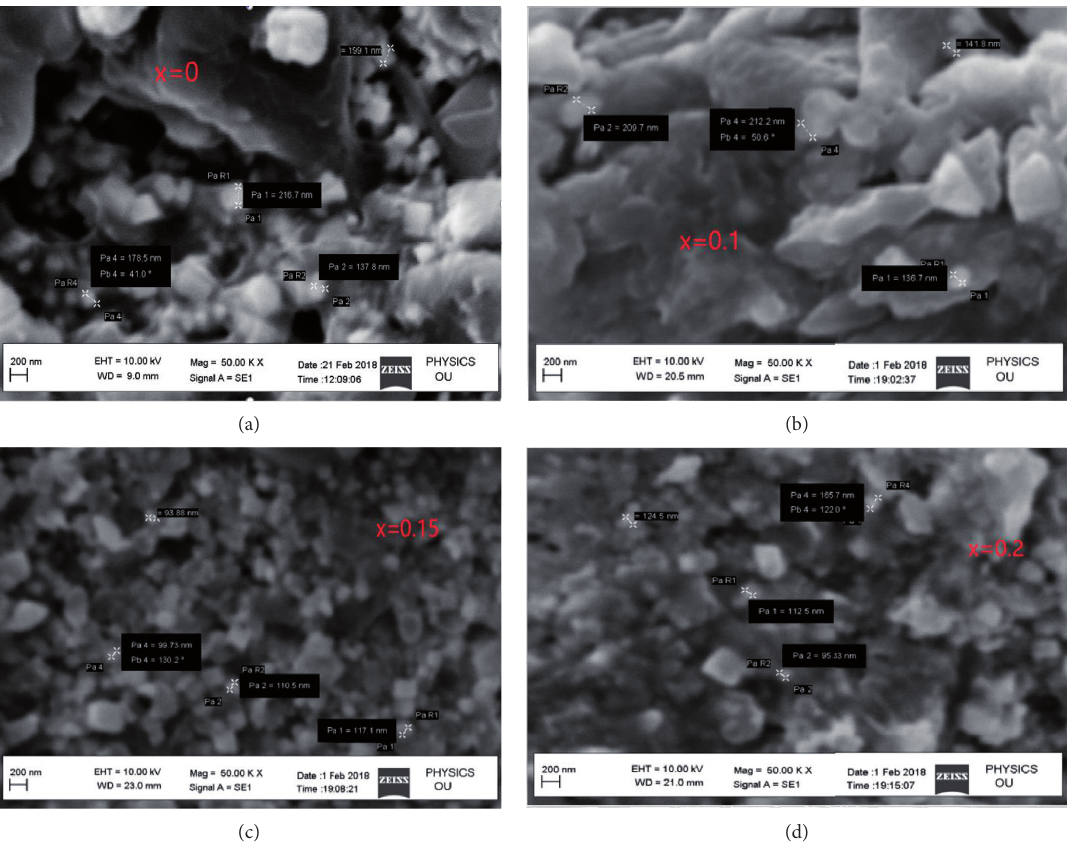
Figure 2: SEM micrographs for Ce 0.5 Sr 0.5 (Co 0.8 Fe 0.2 ) 1 − x Zr x O 3 − δ samples at concentrations of x